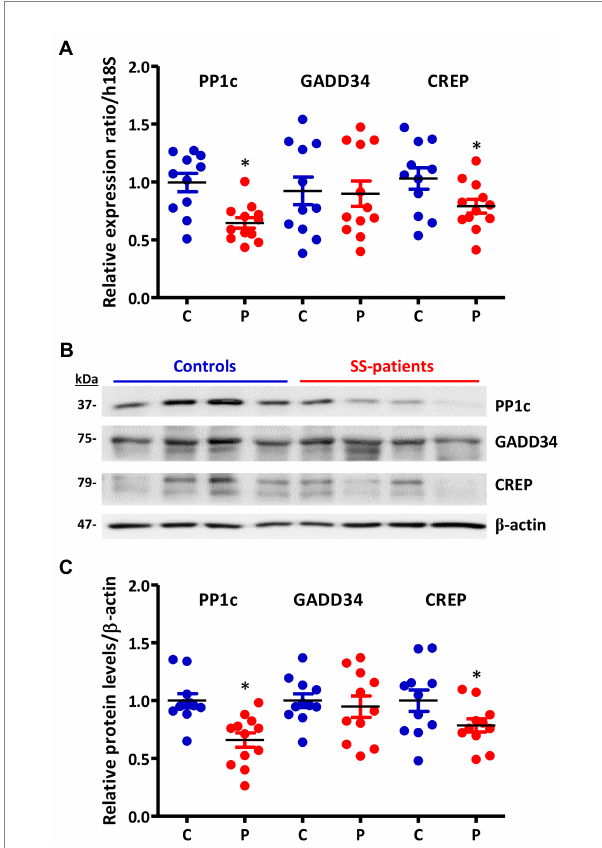
FIGURE 11 Expression of PP1c, GADD34, and CREP in LSGs from control and SS-patients. (A) Dot plot showing PP1c, GADD34, and CREP transcript levels relative to h18S from control (C) and SS-patients (P) ( n = 11C, 12P). (B) Representative images of PP1c, GADD34, and CREP immunoblots from control and SS-patients using β -actin as a loading control. (C) Dot plot showing densitometric analysis of PP1c ( n = 11C y 12P), GADD34 ( n = 11C, 11P), and CREP ( n = 11C, 11P). These experiments were repeated at least three times (*). p values lower than 0.05 were considered